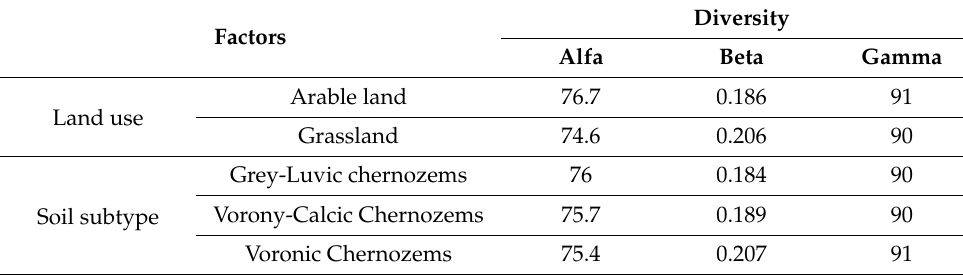
Table 2. Indexes of diversity for arable and nonarable sites and for three subtypes of chernozem.